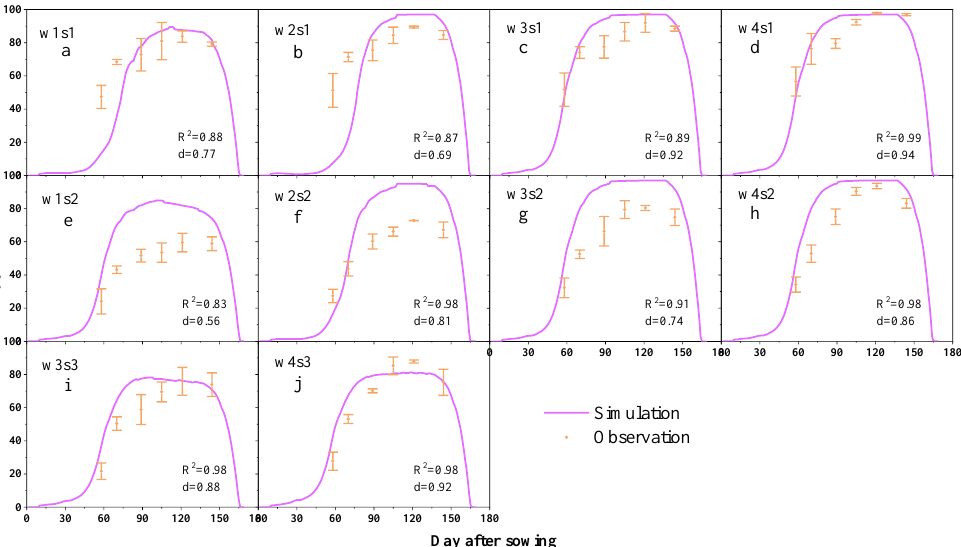
Figure 7. Comparison between observed and simulated canopy cover of cotton for different irrigation and salinity treatments ( a – j ). (The dots represent the measured data, the lines represent the simulated values, the error bars represent standard deviations. W1, W2, W3 and W4 represent irrigation amount of 22.5, 30, 37.5 and 45 mm. S1, S2 and S3 represent the soil salinity of 0.2%, 0.4% and 0.6%.) Table 4. Evaluation of the AquaCrop model for simulating soil water content (SWC), soil salinity, canopy cover (CC), aboveground biomass, and yield with the data set in the 2021 cotton season. Indicator